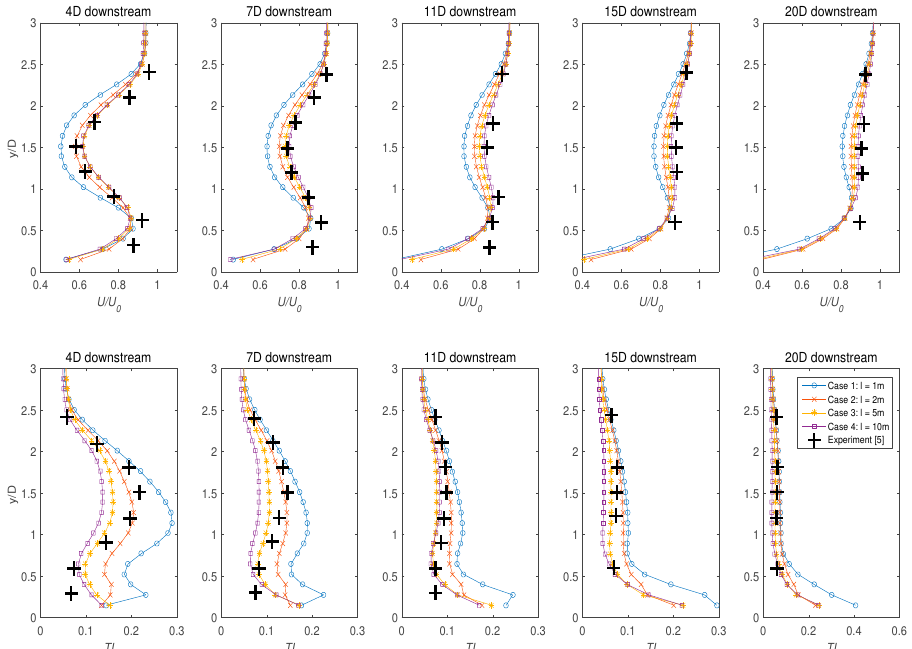
Figure 5. Mesh dependency study for the administered refinement zone at increasing distances downstream of the turbine. The mesh edge length within the refinement zone is varied according to the cases being explored.